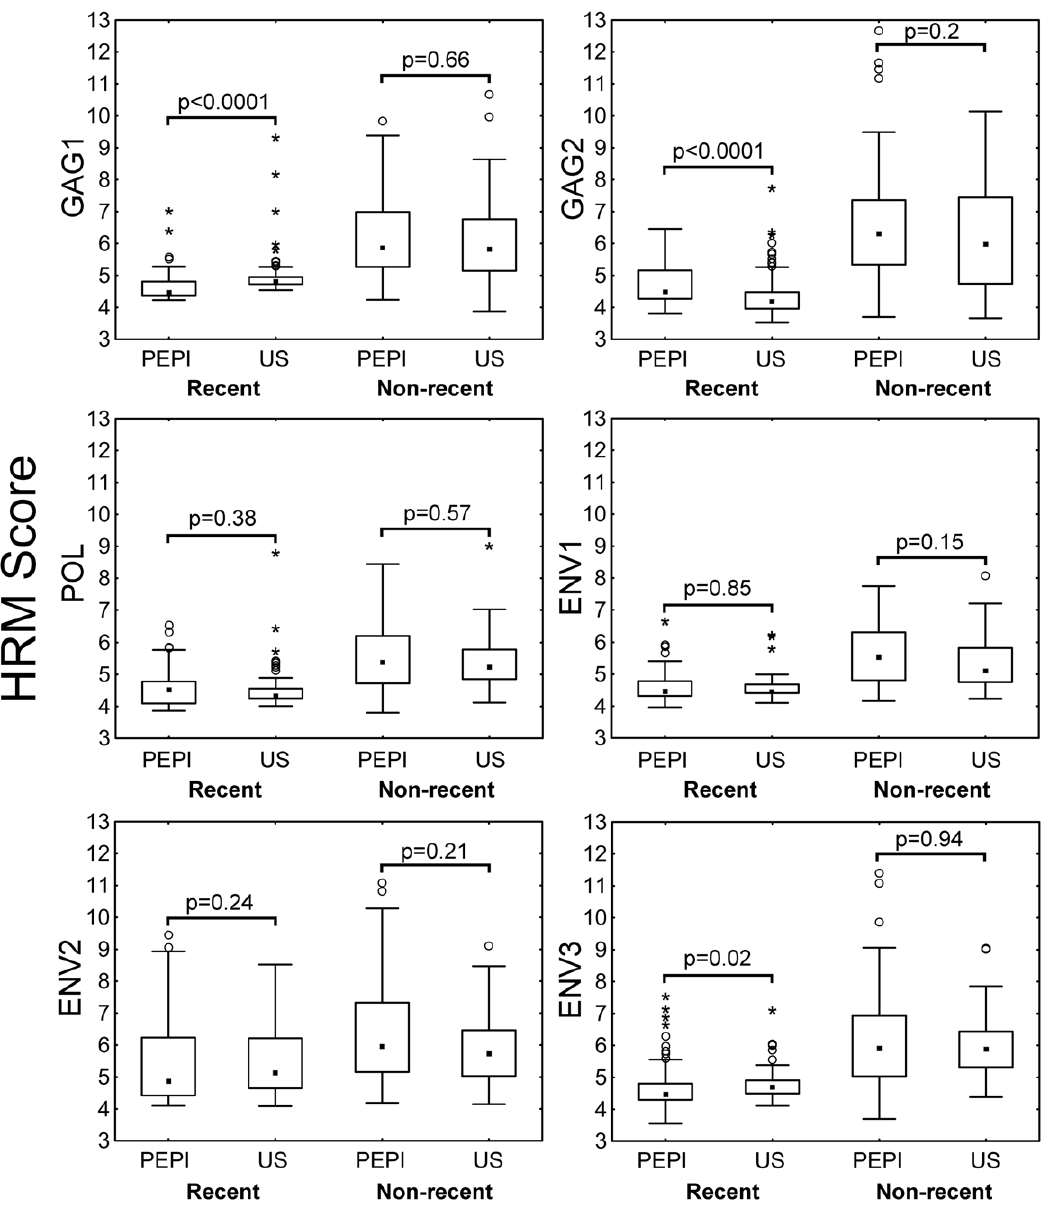
Figure 3. Comparison of HRM diversity in women in the PEPI-Malawi trial and adults in the United States. The figure compares HRM test results obtained for two groups: women in the PEPI-Malawi trial (PEPI, analyzed in this report) and adults in the United States (US, analyzed in a previous study [15]). Results from the PEPI-Malawi trial are shown for women identified as recently infected at enrollment using the MAA (MAA recent, N=73), and women who were known to have non-recent HIV infection at enrollment (known non-recent, N=54); these data were obtained by testing samples collected at the time of study enrollment. Results from adults in the US are shown for adults with known recent HIV infection (N=102, samples collected at the time of HIV seroconversion, median time since last negative HIV test: 189 days, range 14–540 days) and adults with known non-recent HIV infection (N=67, known to be infected for 2 years or more, including 32 with CD4 cell counts , 50 cells/mm 3 and 30 on antiretroviral therapy) [15]. P values were calculated using the Wilcoxon rank sum